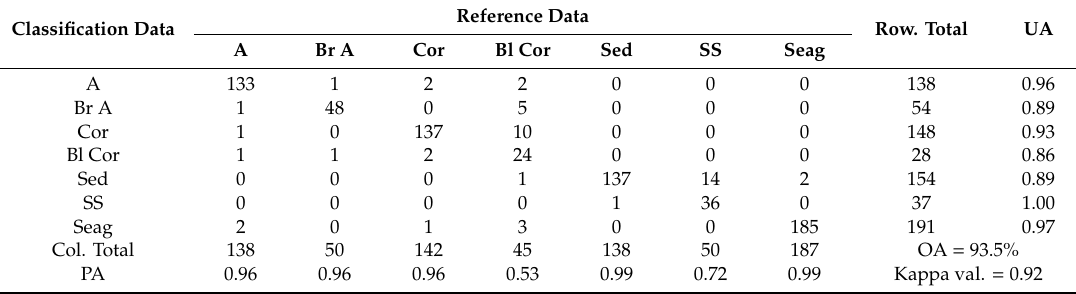
Table 3. The confusion matrix for benthic habitat classification using the fuzzy majority voting (FMV) method.